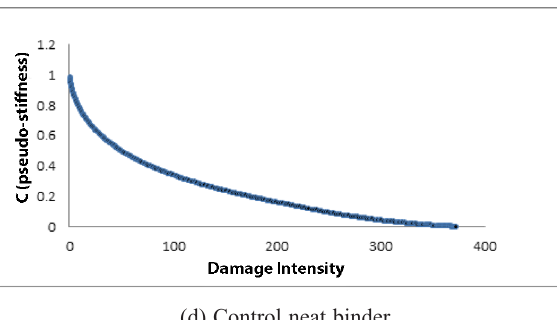
Fig. 8. VECD damage curves drawn from amplitude sweep testing